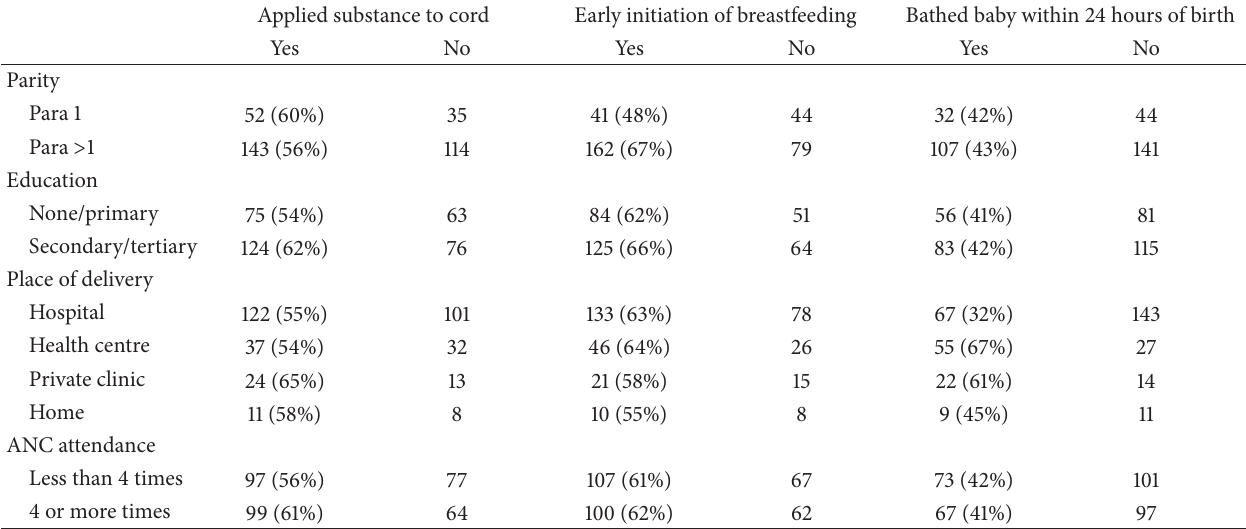
Table 3: Levels of selected newborn care practices in selected demographic, antenatal, and delivery characteristics of mother-infant dyads in Kampala district, Uganda, 2012. Early initiation of